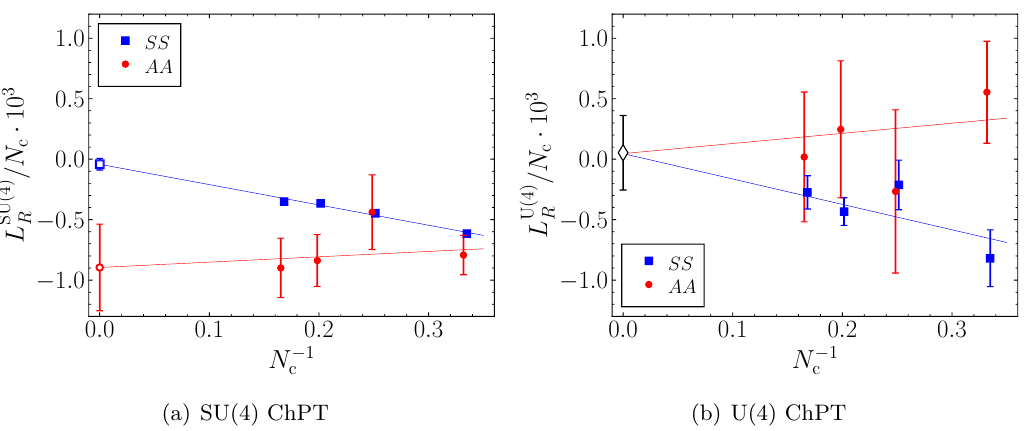
Figure 11 . Results for the fits to ChPT at fixed N c for the SS (blue squares, table 5) and AA (red circles, table 6) channels. The lines are the best fit to eq. (2.12), and empty points represent